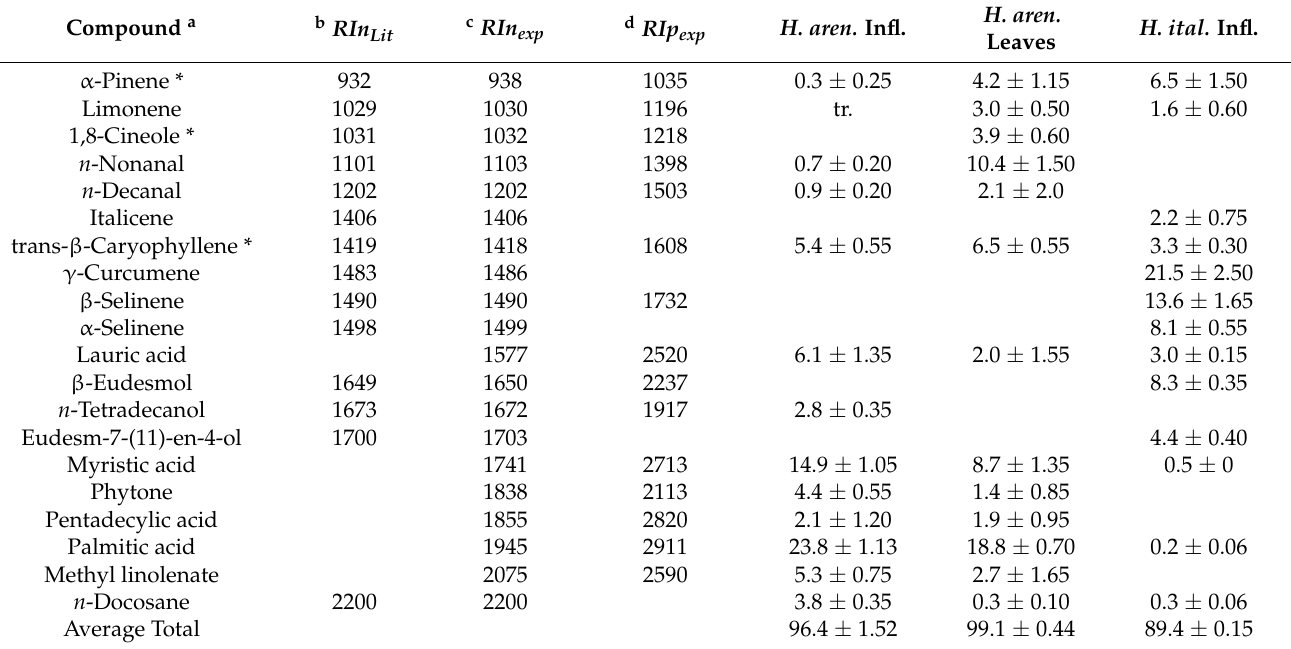
Table 1. The main chemical composition (constituents ≥ 3.0%) of essential oils obtained from H. arenarium inflorescences and leaves and H. italicum